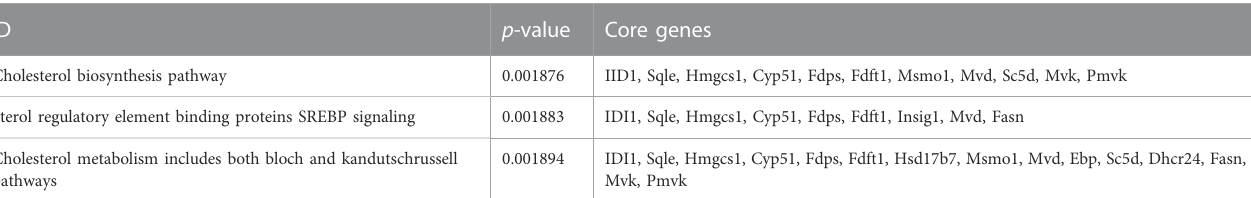
TABLE 4 GSEA crucial pathways information Table (AIC vs.